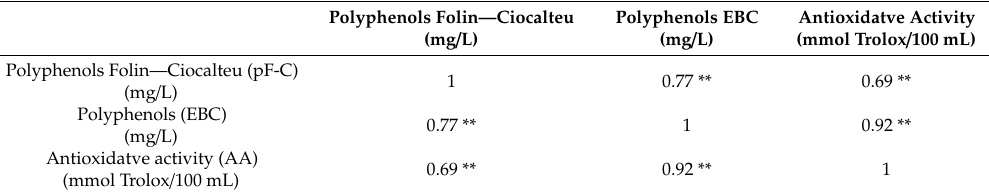
Table 4. Pearson’s correlation coe ffi